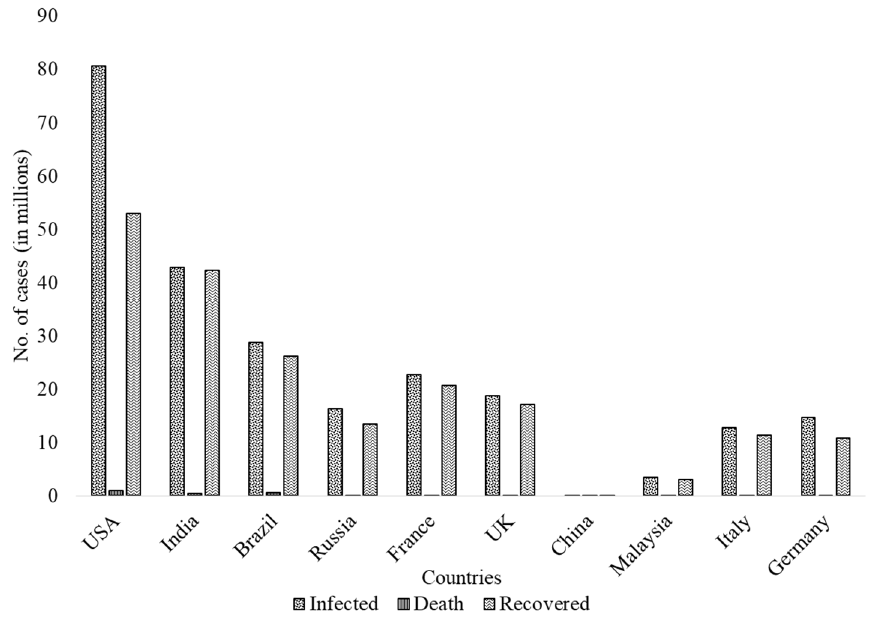
Figure 2. Graphical representation of COVID-19 infections, deaths, and recovered cases in 10 different countries (as of 28 February 2022).